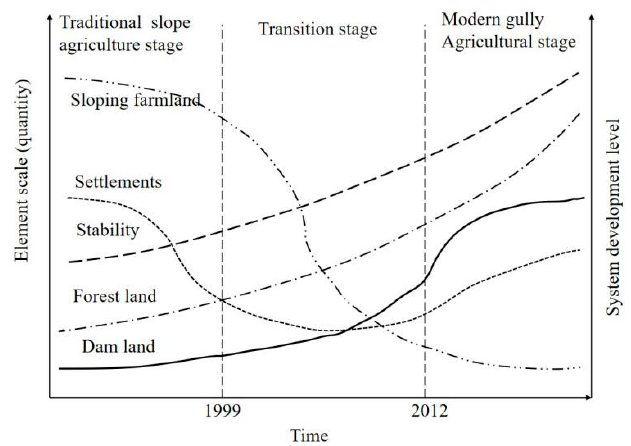
Figure 1. The evolution theoretical model of the gully agricultural production development.